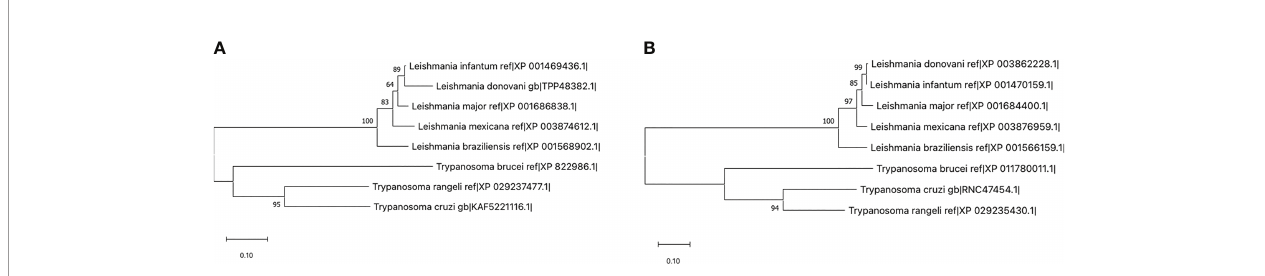
FIGURE 4 | Maximum likelihood trees using the sequences for Leishmania (V.) braziliensis XP_001568902 (A) and XP_001566159.1 (B) in comparison with their respective homologs in other trypanosomatids. Those sequences with an identity percentage of at least 80% through DELTA-BLAST were selected for construction of the tree. Note that the proteins pertaining to the Leishmania genre lie in a different clade than those from Trypanosoma , and that other trypanosomatidae species including Crithidia and Sauroleishmania do not express a protein below the selected identity threshold (Febres et al., 2018; Febres et